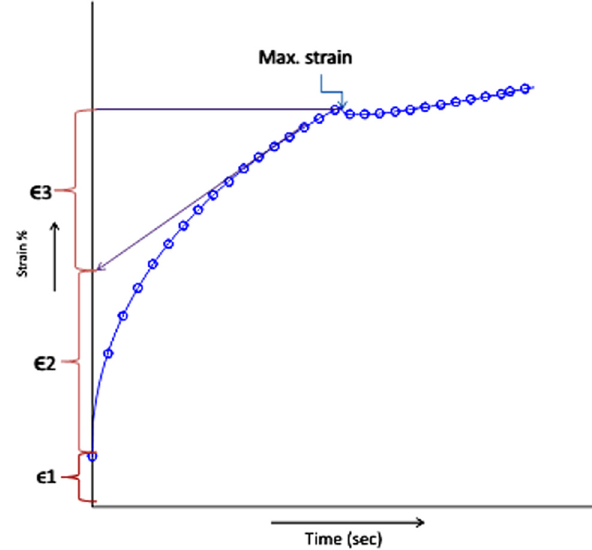
Figure 14: Creep behavior of UP/PS at constant weight 1 N and 20°C.